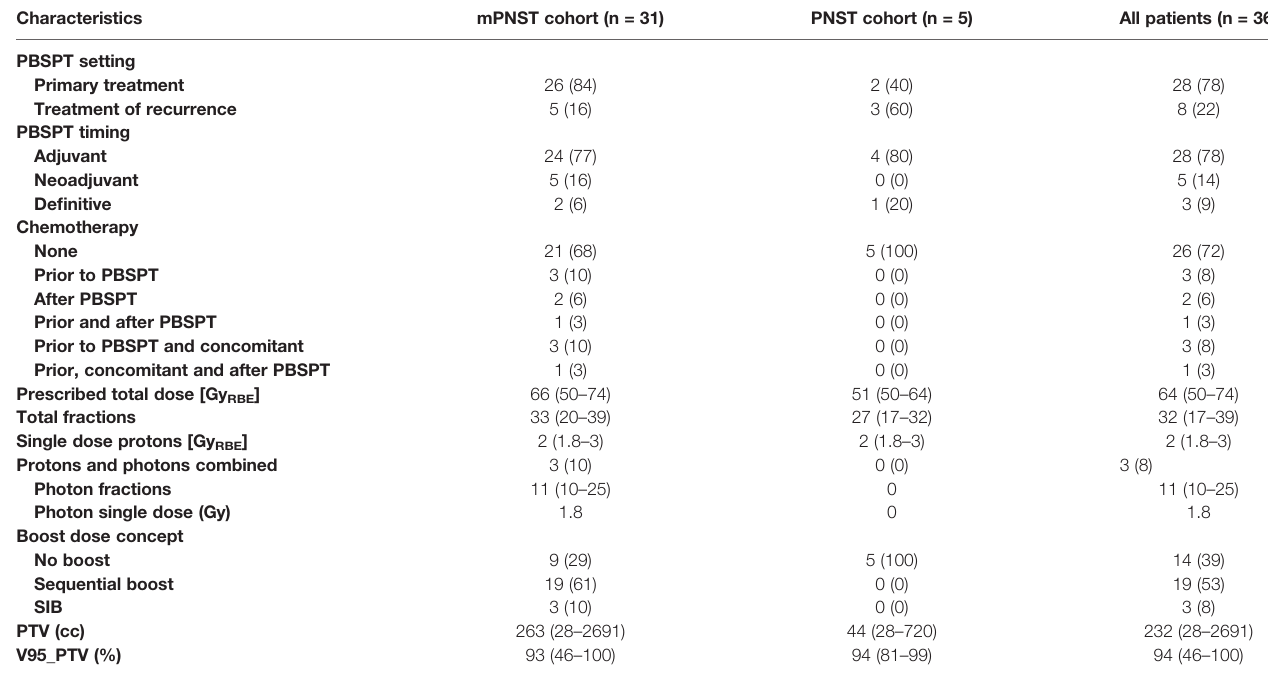
TABLE 2 | Treatment characteristics.